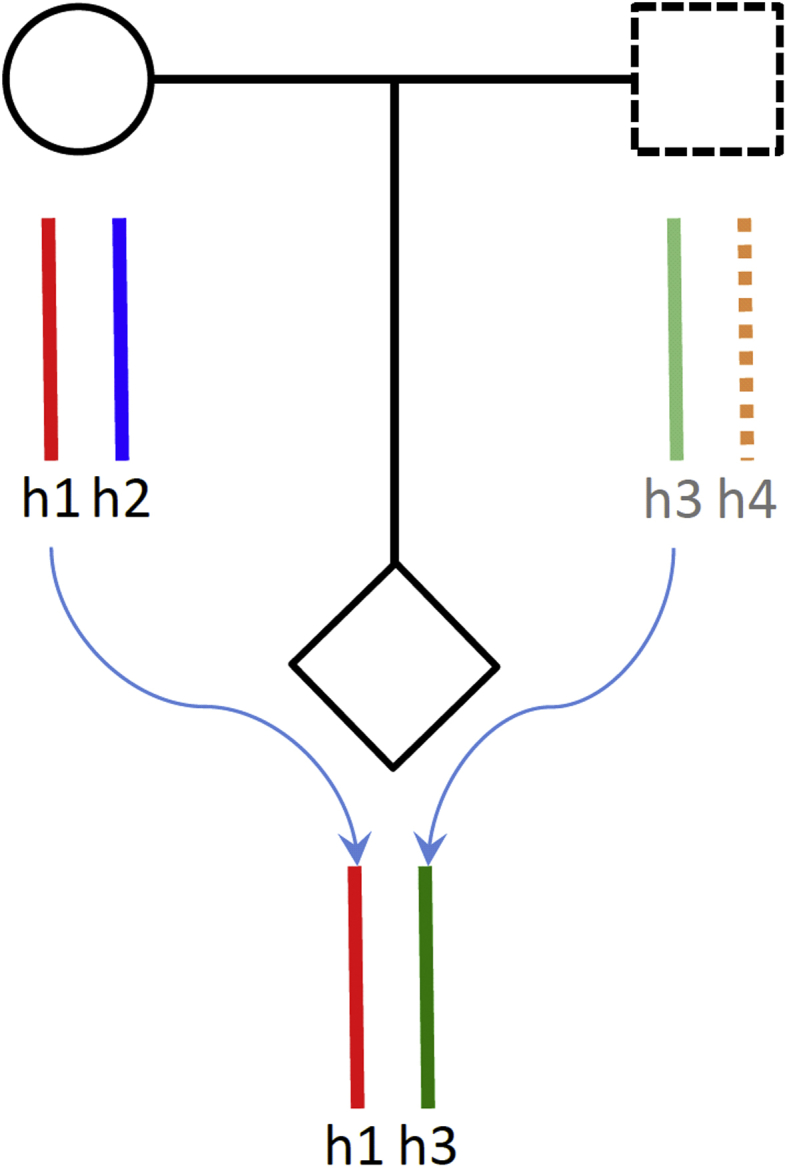
Haplotype transmission in a duo or trio.